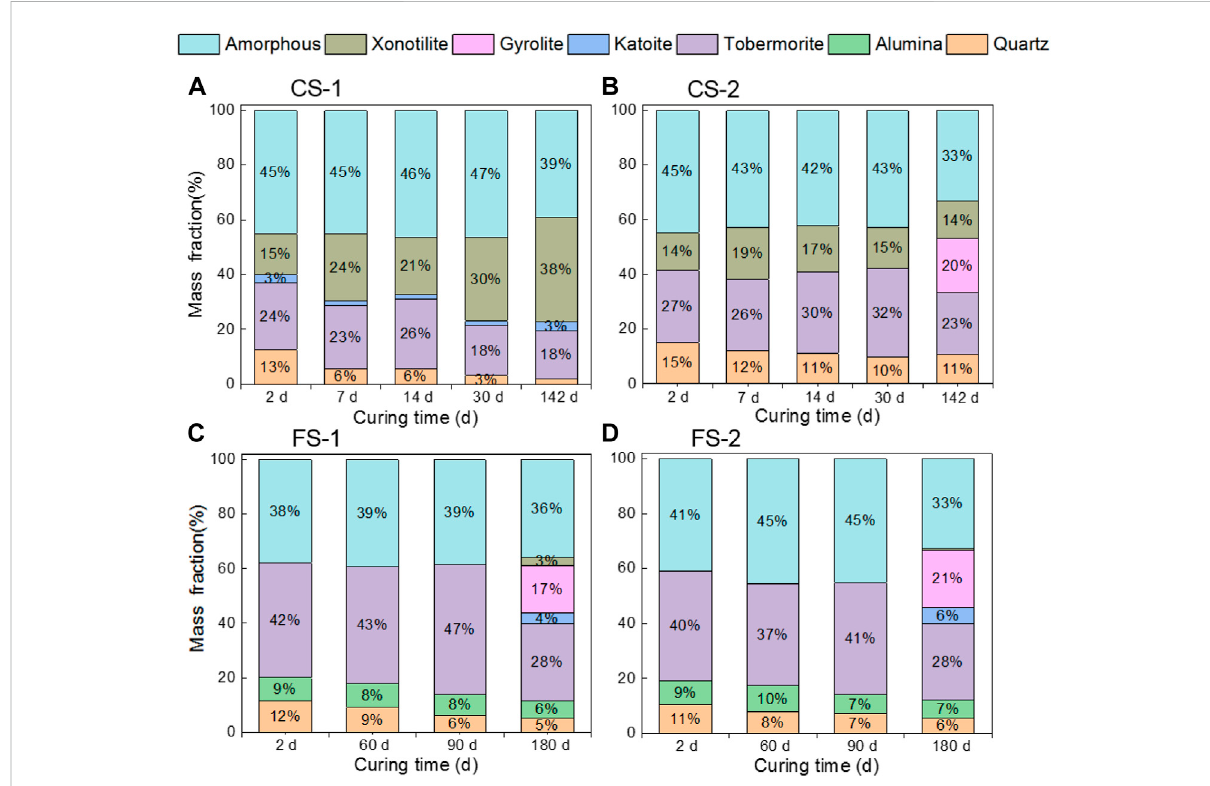
Figure 4. In this method, the quantities of the crystalline